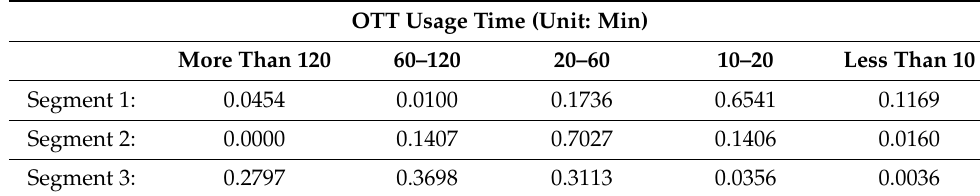
Table 5. Item-response probability by OTT usage time.